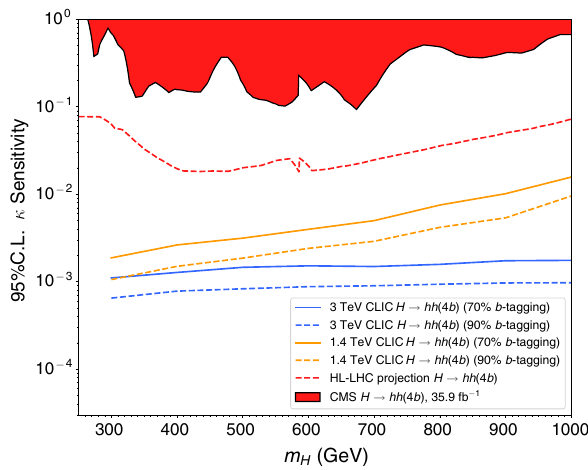
× BR ( H → hh ) as Fig. 9 CLIC 95% C.L. sensitivity to κ = σ H /σ SM √ H s = 1 . 4 TeV a function of m H for e + e − → H νν ( H → hh → 4 b ) at √ s = 3 TeV with L = 2000fb − 1 with L = 1500fb − 1 (orange) and (blue). In both cases the solid line corresponds to a 70% b -tagging efficiency and the dashed line to a 90% b -tagging efficiency. Shown for comparison are the LHC 95% C.L. excluded region from present CMS H → hh → 4 b searches [26] (red region) and the projected HL-LHC (13 TeV, L = 3ab − 1 ) expected 95% C.L. exclusion sensitivity (dashed red line)